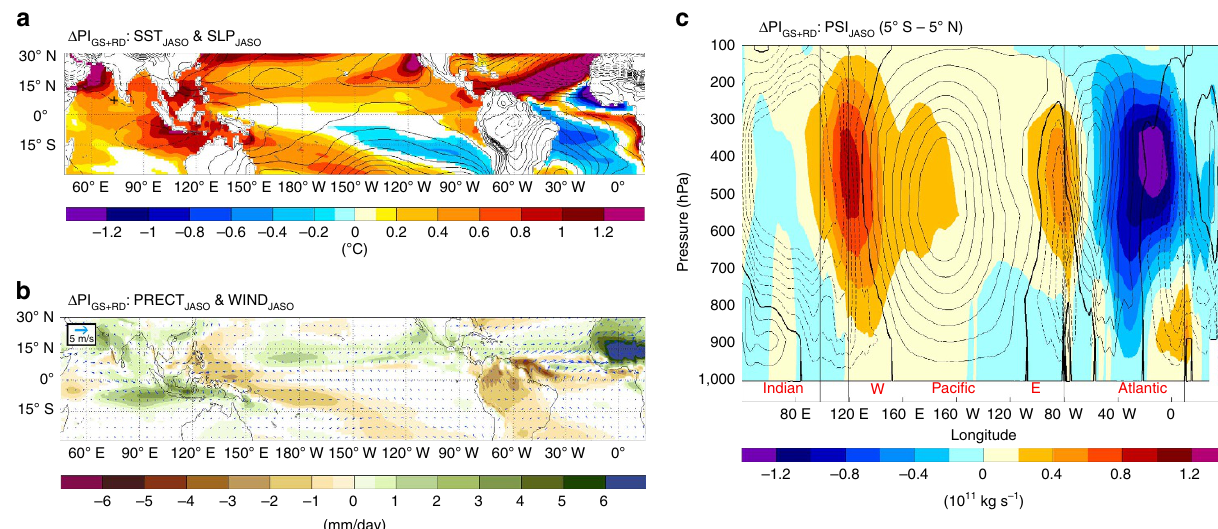
Figure 7 | Changes in surface climate and Walker circulation for the PI GS þ RD simulation. ( a ) Changes in SST (shadings) and SLP (contours: 0.25hPa interval from (cid:2) 3.5 to 3.5hPa; 0 value omitted for clarity) and ( b ) precipitation (shadings) and 10m wind (vectors) for JASO in the PI GS þ RD simulation relative to PI. Only significant values at the 95% confidence level assessed using a two-sided t -test are shaded. ( c ) PI climatological zonal stream function of the Walker circulation (contours: 0.2 (cid:3) 10 11 Kgs (cid:2) 1 interval from (cid:2) 1.4 to 1.4 (cid:3) 10 11 Kgs (cid:2) 1 ; 0 line in bold) and associated changes (shadings) in the PI GS þ RD experiment relative to the PI for JASO.